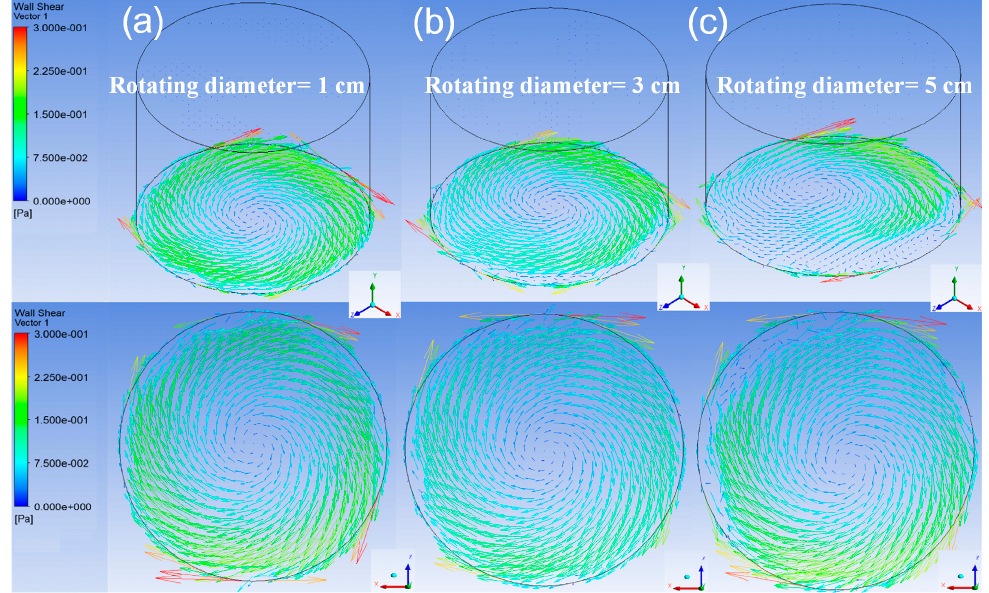
Figure 4. The isometric view (upper) and top view (lower) of the shear stress distributed on the bottom surface of the container. The shaker’s rotational speed is 120 rpm and the rotational diameter is ( a ) 1 cm, ( b ) 3 cm, and ( c ) 5 cm, respectively. The coordinate is X ’ YZ ’ system. (Container’s diameter = 3 cm)